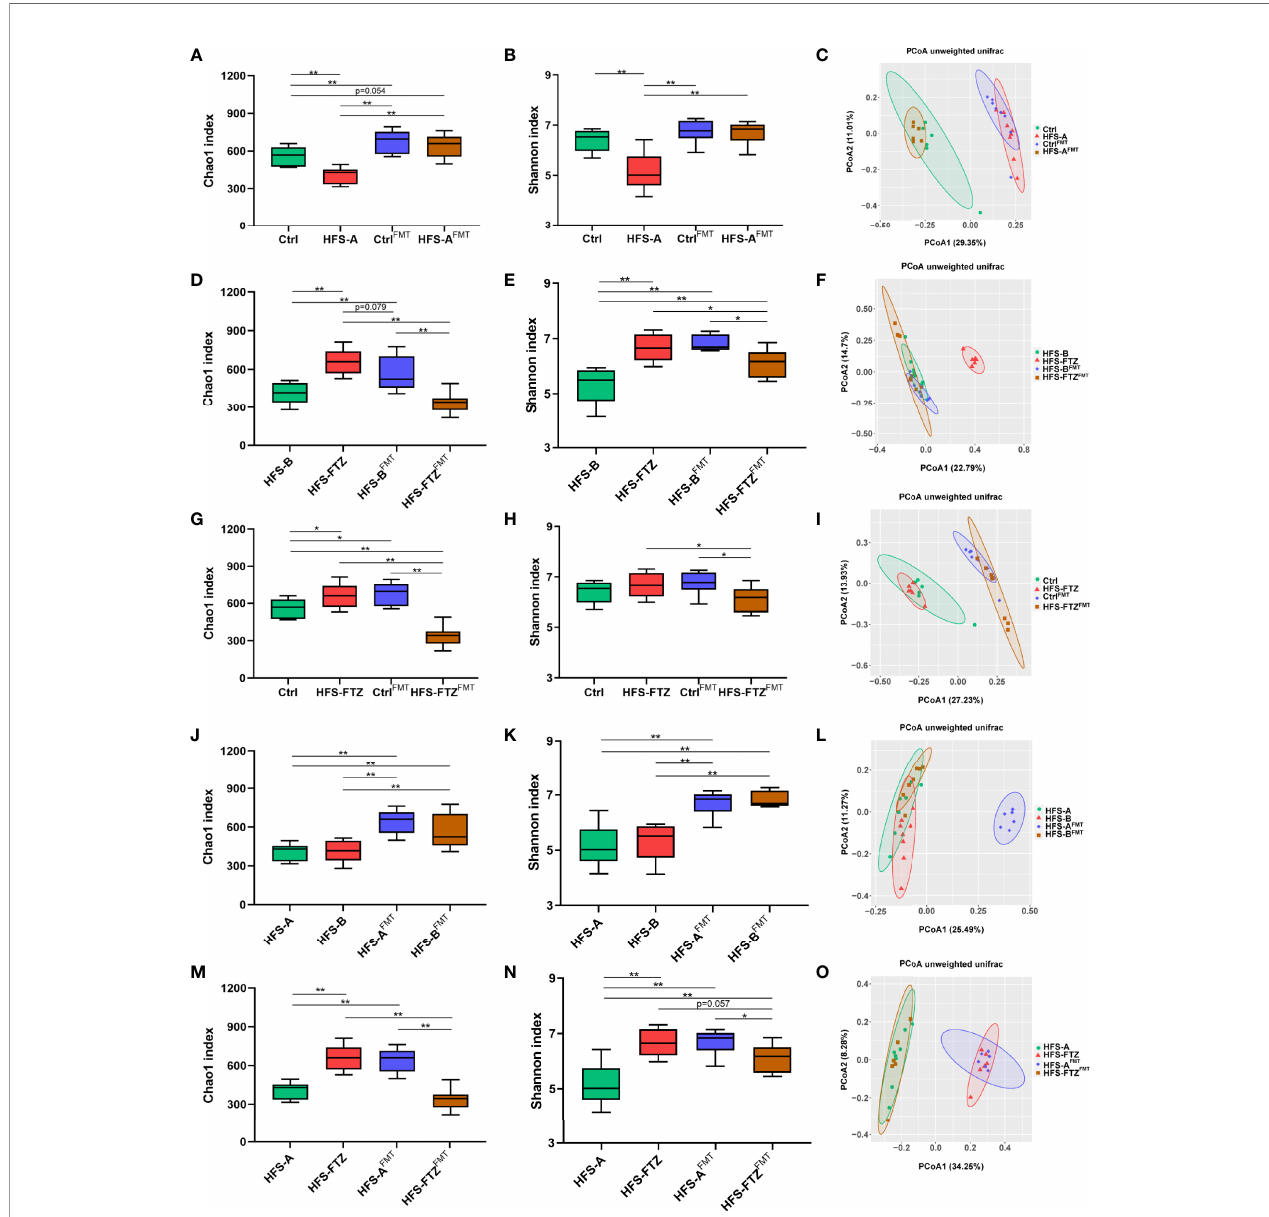
FIGURE 8 | Reshaped intestinal microbiota by transplantation with FTZ-modulated gut fl ora contributed to the hypotensive effect. (A – C) Comparative analysis of gut microbiota between the Ctrl and HFS-A groups. (D – F) Comparative analysis of gut microbiota between the HFS-B and HFS-FTZ groups. (G – I) Comparative analysis of gut microbiota between the Ctrl and HFS-FTZ groups. (J – L) Comparative analysis of gut microbiota between the HFS-A and HFS-B groups. (M – O) Comparative analysis of gut microbiota between the HFS-A and HFS-FTZ groups. ∗ p < 0.05, ∗∗ p < 0.01. n = 6~8 per group. FTZ, Fufang-Zhenzhu-Tiaozhi capsule; HFS, high fructose and high